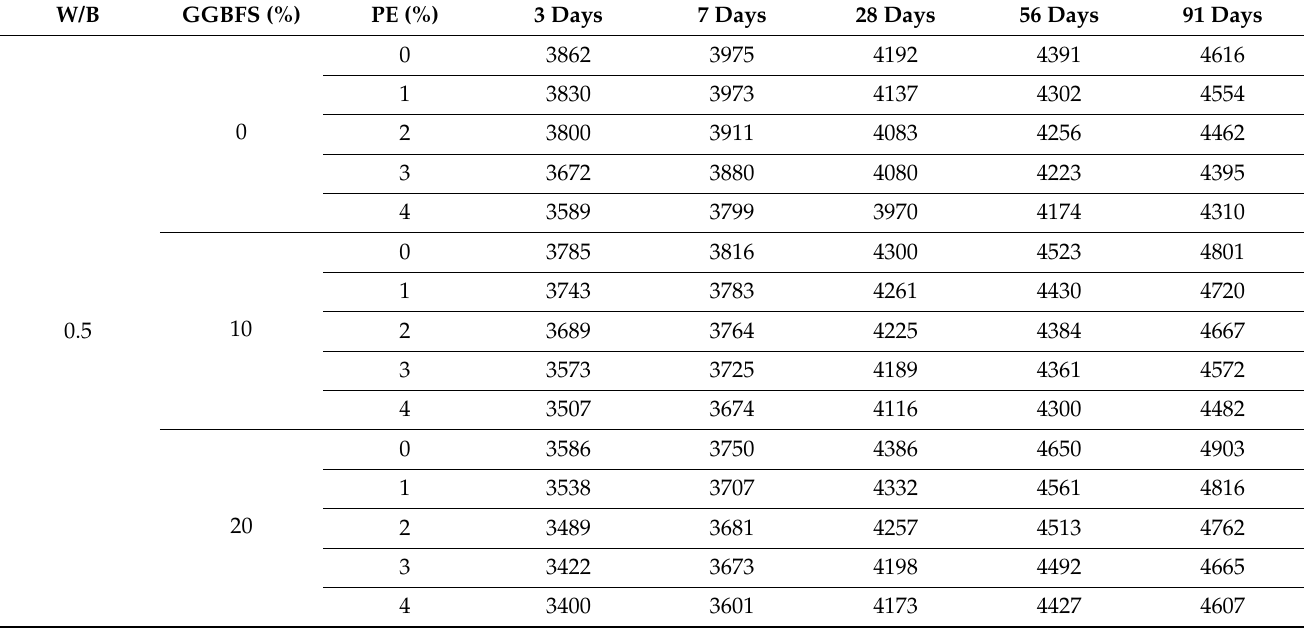
Table 6. Ultrasonic pulse velocity of cement mortars with the addition of different ratios of waste PE and GGBFS replacement (unit: